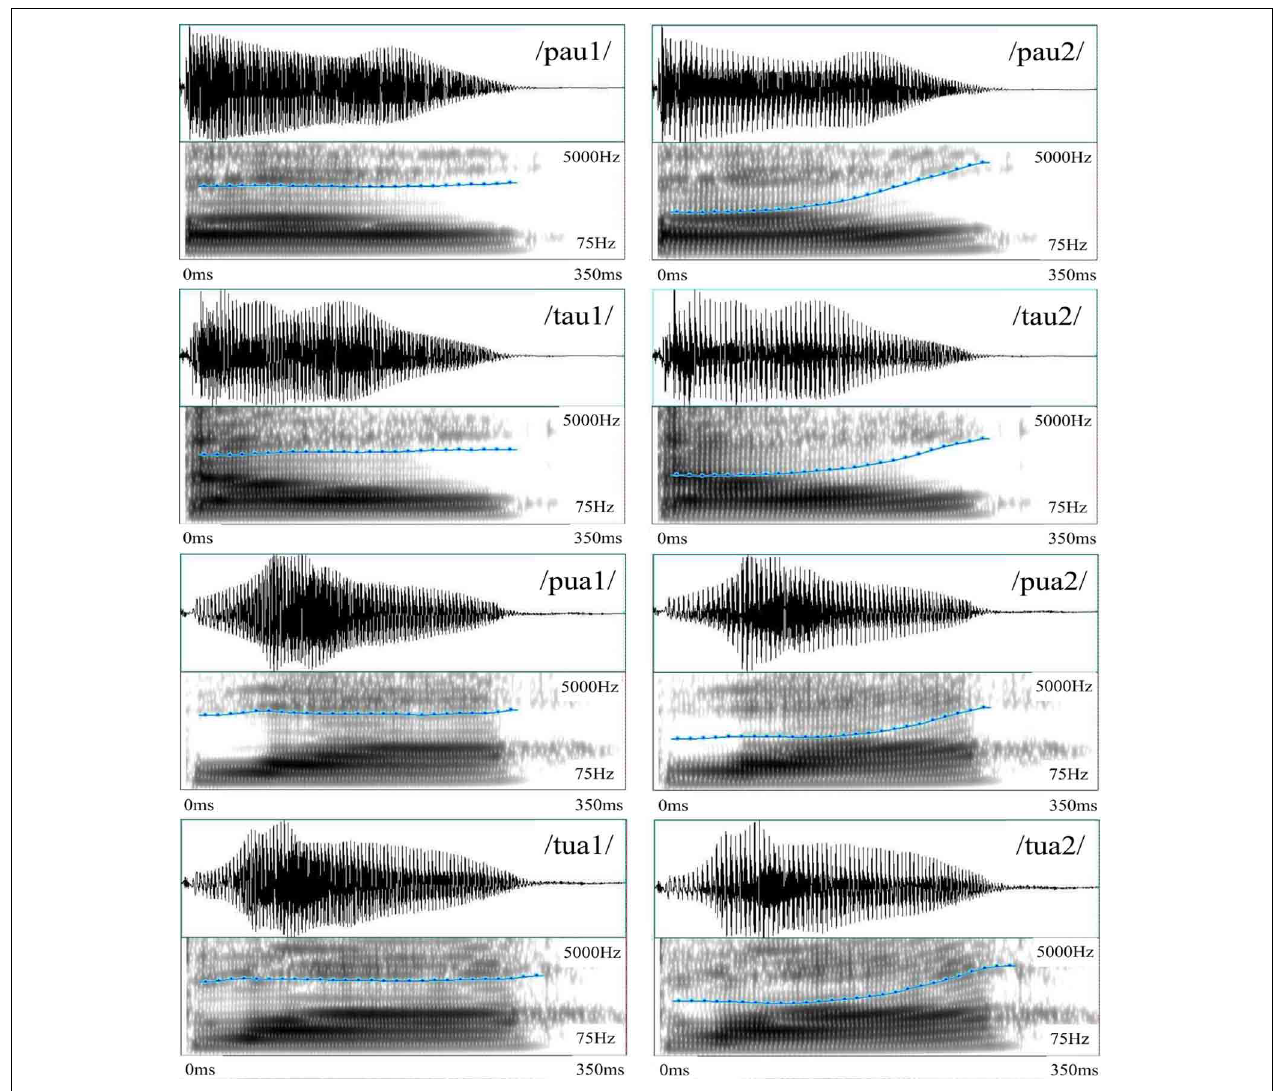
FIGURE 2 | Sound waveforms and spectrograms of the eight Mandarin syllables in Experiment 1. The pitch contours of the syllables having level tones have stable level portions throughout the duration, whereas those of the syllables having rising tones start with a level portion (about half of the